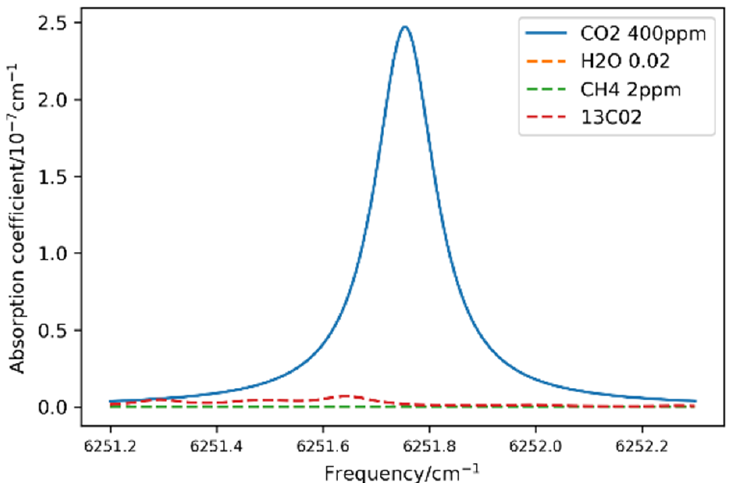
Figure 3. Simulation of CO 2 absorption feature and background interference from of 13 CO 2 , H 2 O vapor and CH 4 .